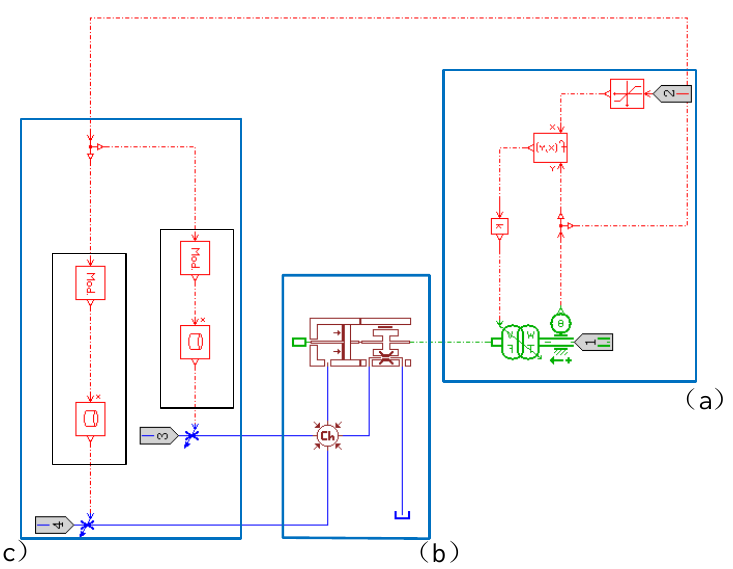
Figure 3. Single-plunger model. ( a ) Single plunger movement law; ( b ) Plunger; ( c ) Distribution.